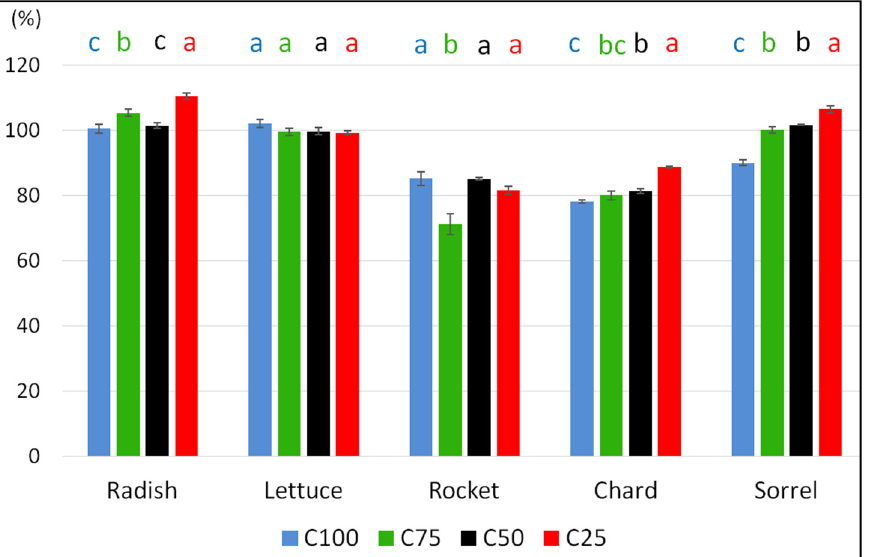
Figure 2. SPAD index measured at the end of the pot trial, in relation to the control (%) at the different doses of compost added to the growth media. Mean values are expressed as percentages relative to the control (n = 3). Bars represent SD of the means. Different letters indicate significant differences ( p = 0.05) among the growing media, according to factorial ANOVA combined with Tukey post-hoc test.